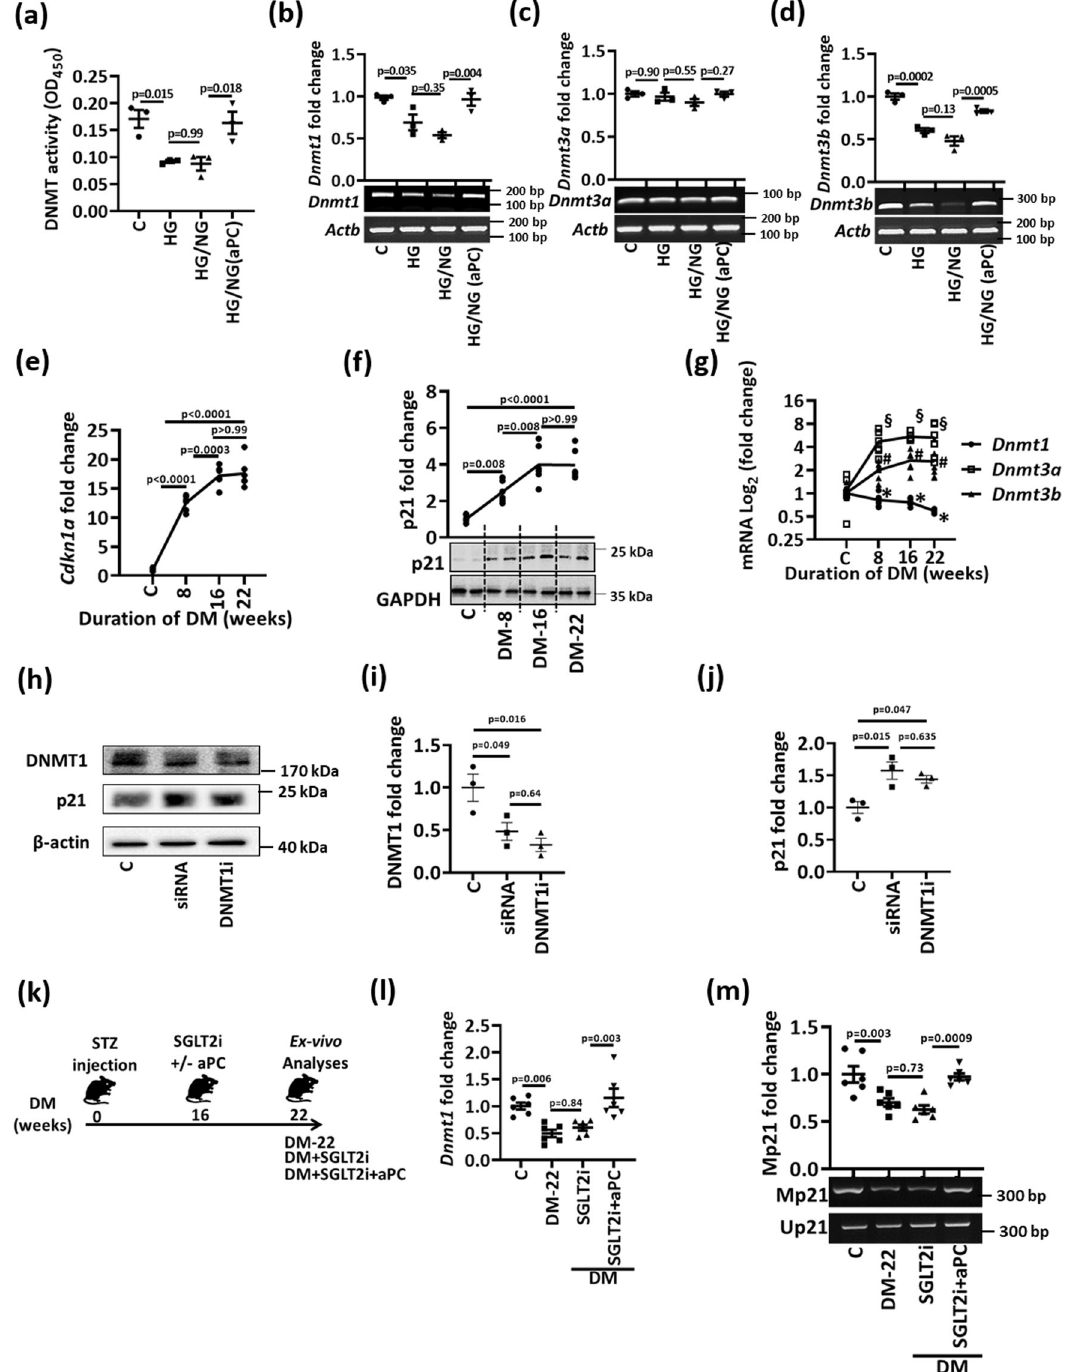
area (FMA, d ), the latter re fl ecting glomerulosclerosis in experimental groups (as described in a ). e Exemplary immunoblot (bottom; loading control: GAPDH) and dot plot summarizing results (top) of renal KIM-1 expression in experimental groups (as described in a ). f , g Dot plots summarizing percentage of SA- β -gal. positivearea( f )andpercentageof γ -H2A.Xpositivecells( g )inexperimentalgroups (as described in a ). h , i Exemplary histological images of glomerular nephrin expression (green, DAPI nuclear counterstain, blue, h ), and dot plot summarizing nephrinstainingintensityfoldchange( i )inexperimentalgroups(asdescribedin a ). Dotplotsre fl ectingmean±SEMofsixmicepergroup;one-wayANOVAwithSidak ’ s multiple comparison test. Source data are provided as a Source Data fi